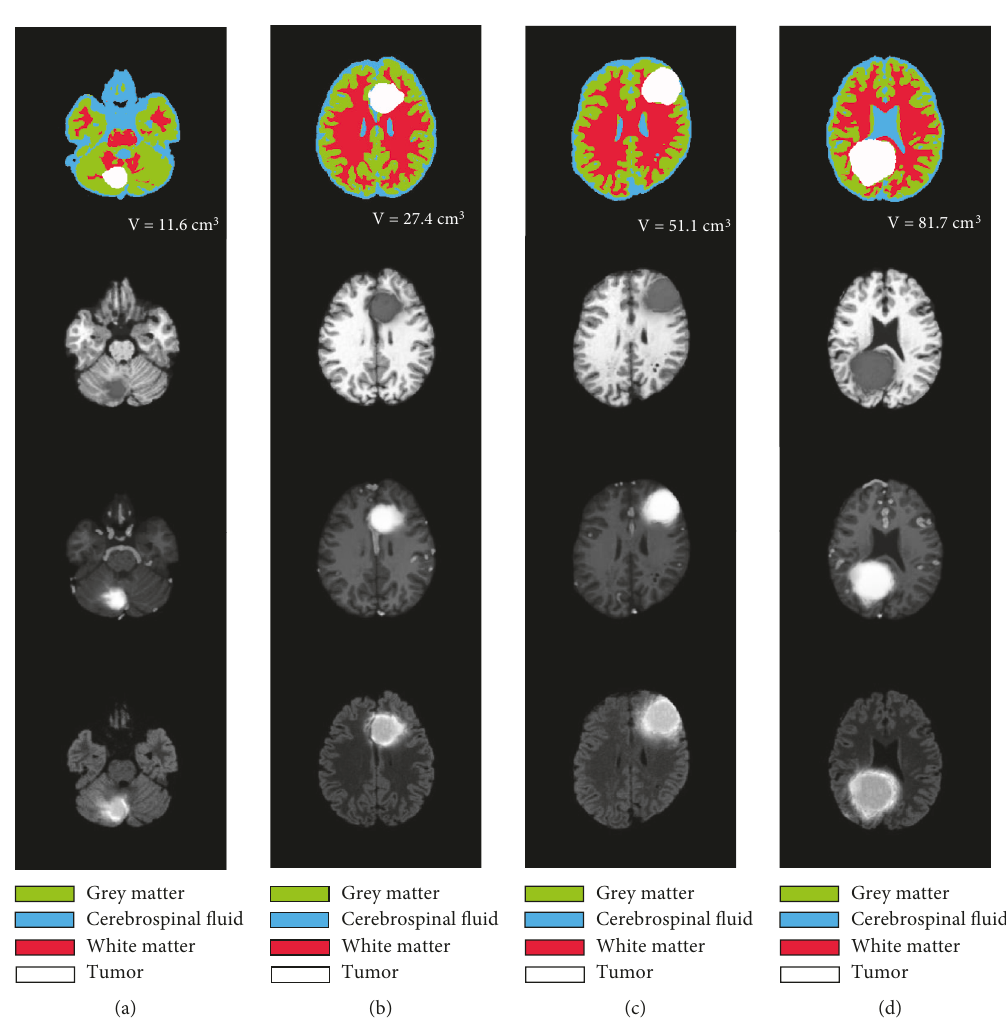
Figure 1: Synthetic T1, T1 contrast, and Flair images of four patients with tumors of different volumes with their ground truth. (a) Tumor with 11.6 cm 3 of volume. (b) Tumor with 27.4 cm 3 of volume. (c) Tumor with 51.1 cm 3 of volume. (d) Tumor with 81.7 cm 3 of